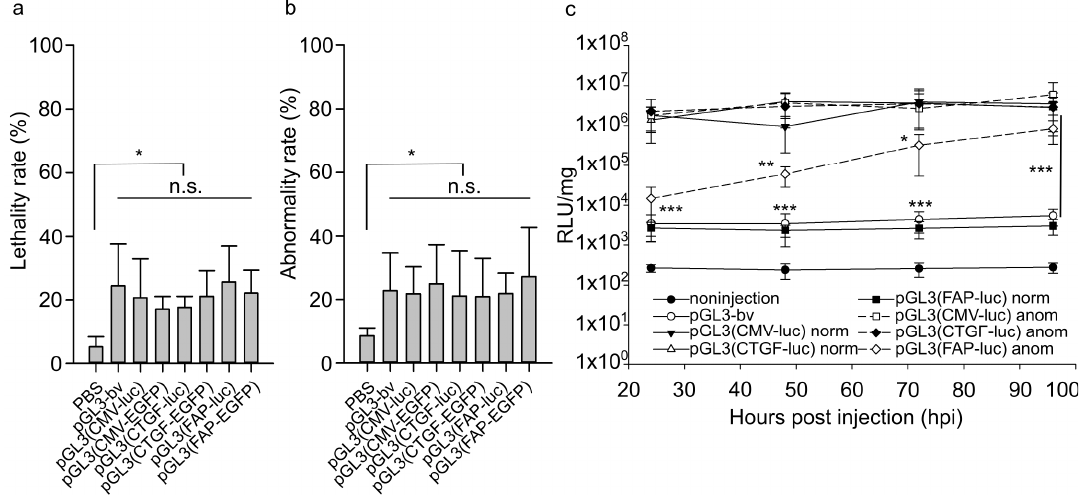
Figure 5. Lethality ( a ) and abnormality ( b ) rates in developing zebra fi sh embryos 24 h after injection of 30 a tt omoles of pGL3(CMV-EGFP), pGL3(CTGF-EGFP), pGL3(FAP-EGFP), pGL3(CMV-luc), pGL3(CTGF-luc), pGL3(FAP-luc), pGL3-bv, and bu ff er solution. Ordinate, the proportion of surviv- ing animals relative to injected ones or proportion of abnormal animals relative to surviving ones 24 h after injection. The values for the uninjected group were taken as the baseline. The data were averaged for three independent experiments. ( c ) Luciferase activity in normal and abnormal zebra fi sh embryos injected with 30 a tt omoles of pGL3(CMV-luc), pGL3(CTGF-luc), pGL3(FAP-luc), or pGL3-bv. Abscissa, hours after injection; ordinate, relative luminescence units (RLU) normalized to 1 mg total protein in embryonic lysates, logarithmic scale. The dashed lines indicate the luciferase activity in abnormal individuals. The values were averaged for three independent experiments with three replicates for each point ( n = 27). Signi fi cant di ff erences in the luciferase activity in normal embryos after the injection of pGL3(CMV-luc) and pGL3(CTGF-luc) relative to vector pGL3(FAP- luc) were observed from 24 to 96 h after injection ( p < 0.001). The signi fi cance of di ff erences in the luciferase activity in abnormal embryos was observed 24 h ( p < 0.01), 48 h ( p < 0.01), and 72 h ( p < 0.05) after the injection of pGL3(CMV-luc) and pGL3(CTGF-luc) relative to vector pGL3(FAP-luc). The signi fi cance of di ff erences in the luciferase activity in abnormal embryos relative to the one in normal embryos from 48 to 96 h after the injection of pGL3(FAP-luc) was p < 0.001. Error bars indi- cate standard deviation (SD), * p < 0.05, ** p < 0.01, *** p < 0.001; n.s. — not signi fi cant for all columns in the speci fi ed range.